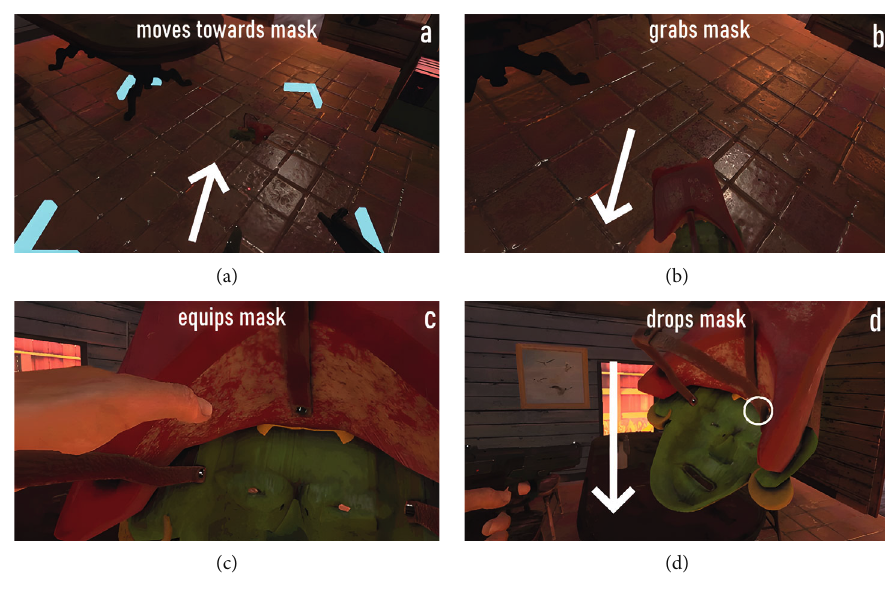
Figure 6: Unsuccessful attempt to equip a